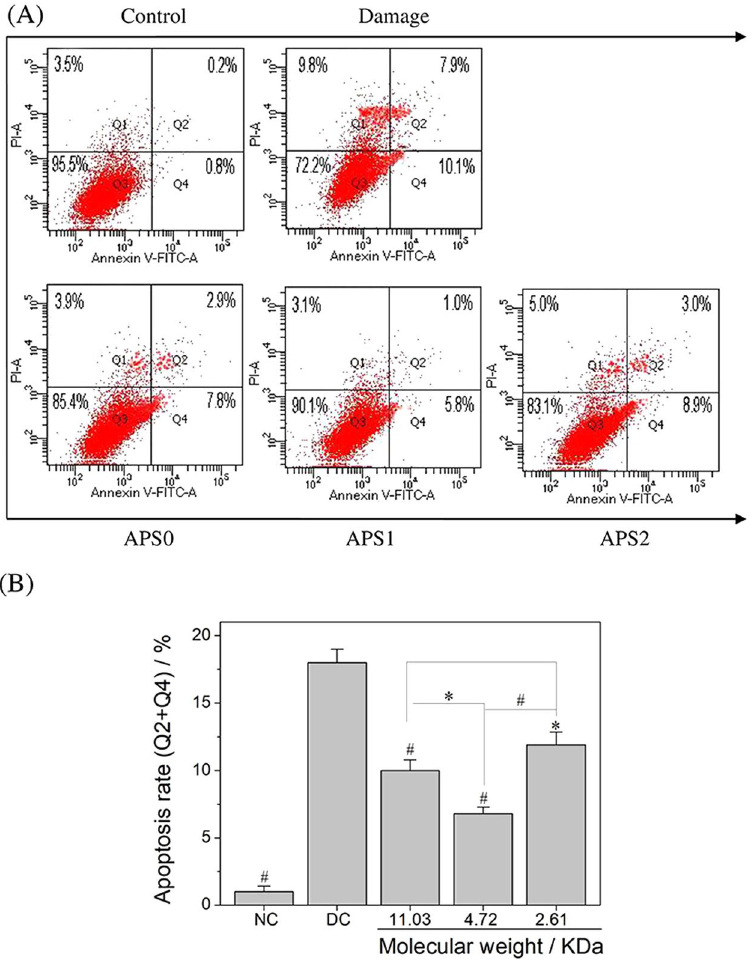
Figure 8. Changes in apoptosis and necrosis rate of oxalate damaged HK-2 cells after repair by different Mw APS (60 μ g/mL) for 10 h. ( A ) Cell apoptosis and necrosis rate detected by flow cytometry. ( B ) Quantitative results of apoptosis rate (Q2 + Q4). Compared with DC group, * P < 0.05, # P < 0.01.